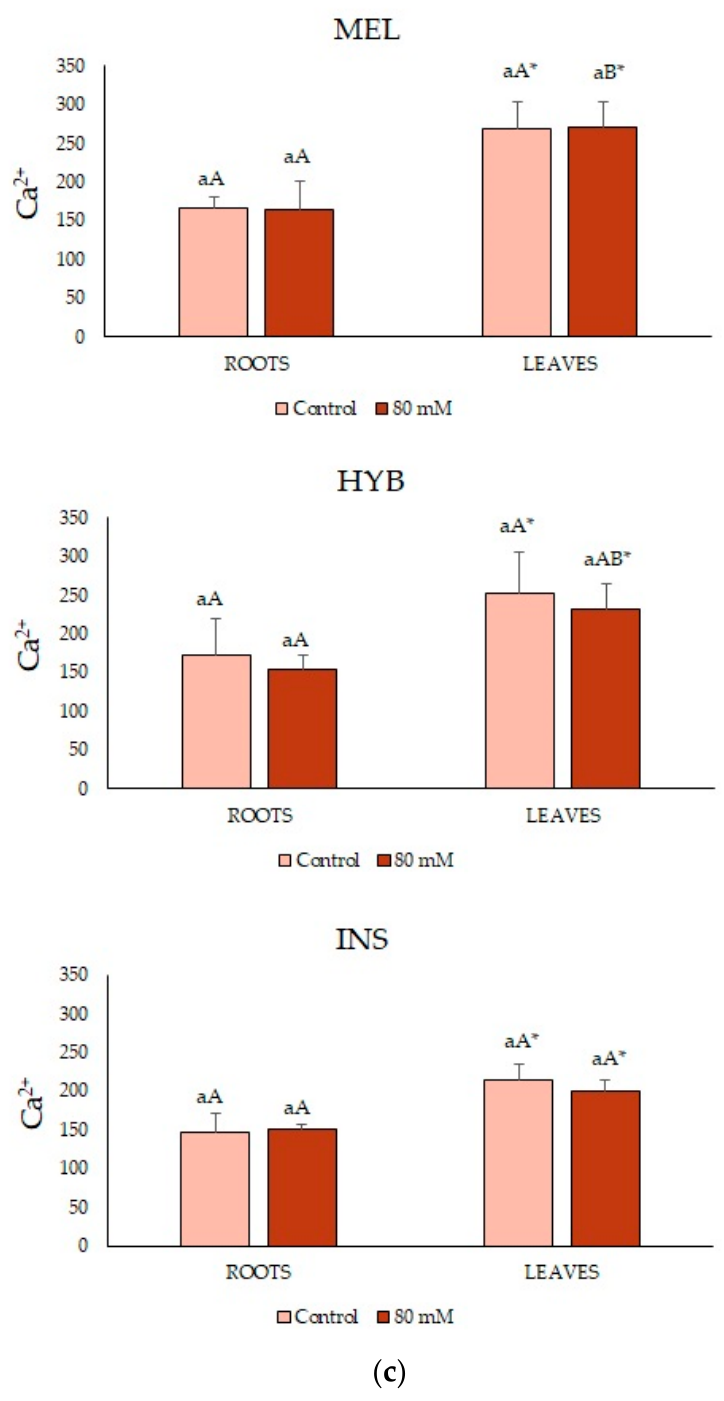
Figure 9. Na + ( a ), K + ( b ), and Ca 2+ ( c ) content ( μ mol g − 1 dry weight) in roots (left) and leaves (right) (mean ± SD; n = 5) in Solanum melongena (MEL), Solanum insanum (INS) and their hybrid (HYB) in the conditions tested (control, 80 mM of NaCl). Different lowercase letters within the same genotype indicate statistically significant differences between treatments, different uppercase letters within the same treatment indicate statistically significant differences between genotypes, and an asterisk indicates statistically significant differences between roots and leaves for the same treatment and genotype ( p < 0.05), according to the Student–Newman–Keuls multiple range test.